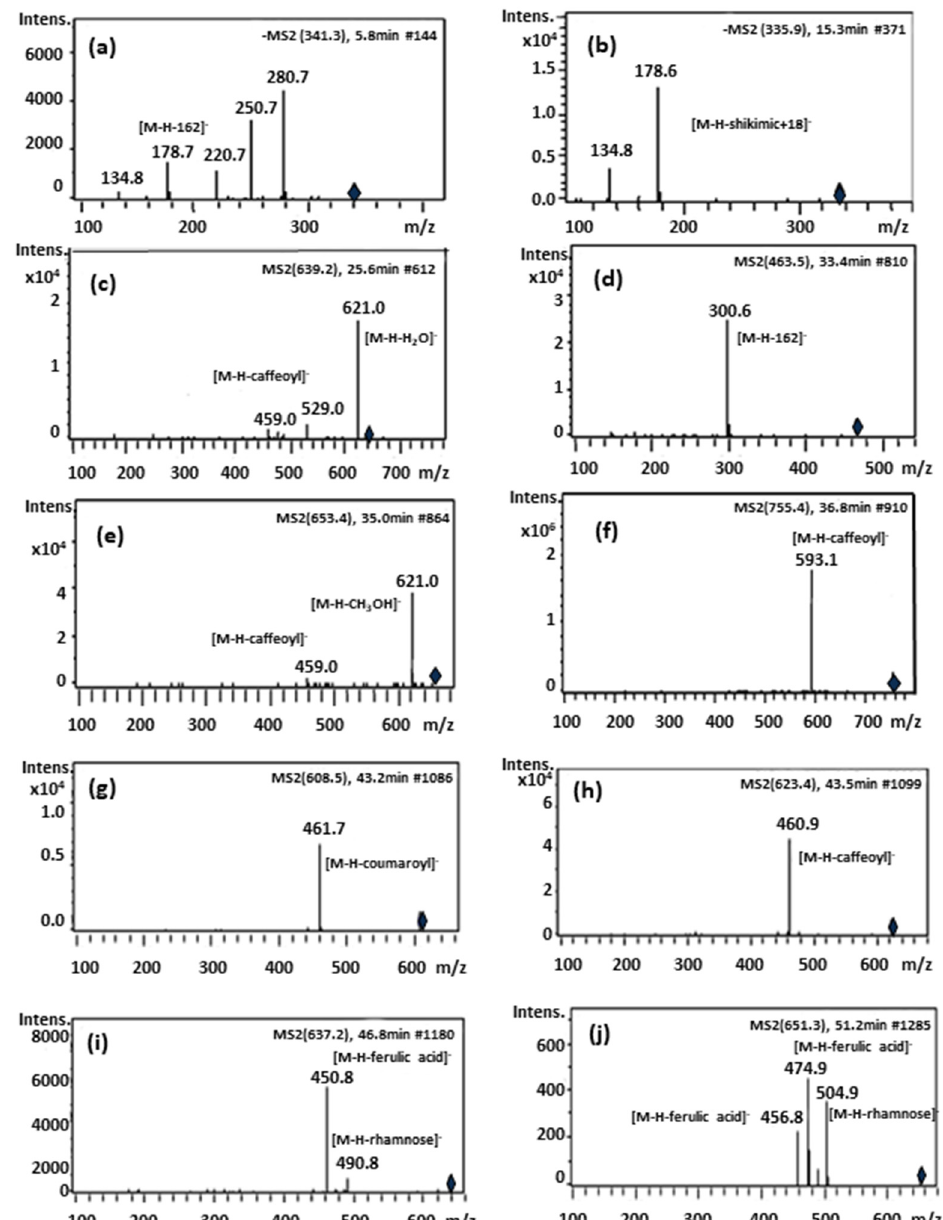
Figure 3. Most representative MS-MS spectra of Buddleja globosa compounds no reported previously. The spectra correspond to: ( a ) caffeoylglucoside, ( b ) caffeoylshikimic acid, ( c ) β -hydroxy-verbascoside or β -hydroxy-isoverbascoside, ( d ) quercetin-3- O -glucoside, ( e ) campneoside I, ( f ) forsythoside B, ( g ) lipedoside A, ( h ) forsythoside A, ( i ) eukovoside and ( j ) martynoside.